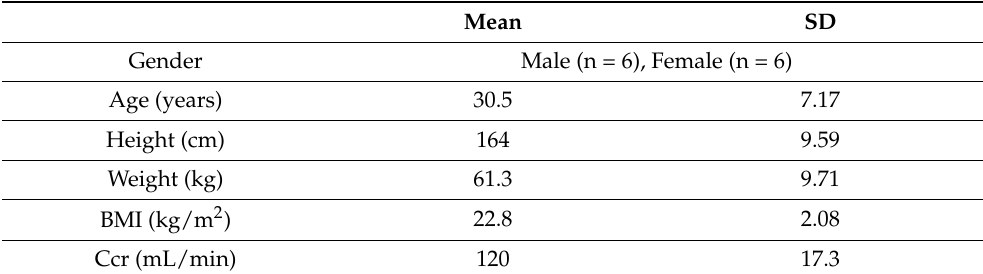
Table 1. Mean (SD) baseline demographic characteristics of healthy Chinese subjects (n =